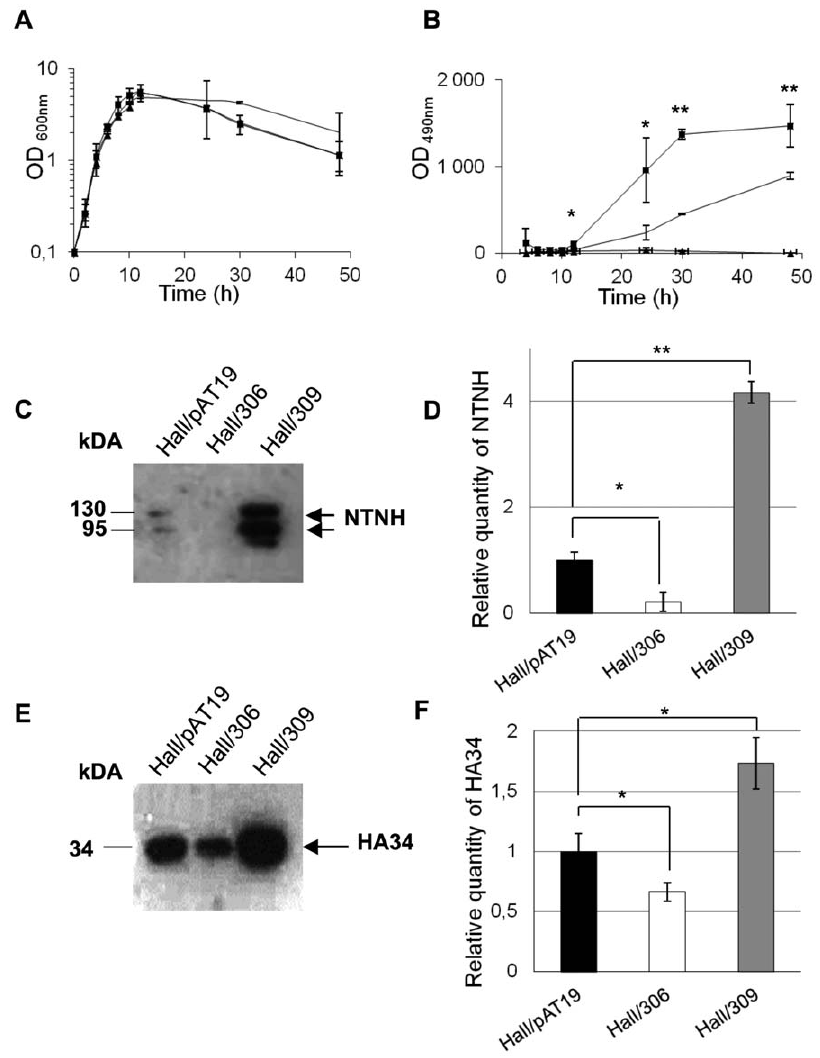
Figure 1. Growth kinetics, BoNT/A, NTNH, and HA34 production in Hall botR/A isogenic antisense strains. (A) Growth curves of Hall/ pAT19 (empty vector), Hall/306 (antisense botR/A mRNA), and Hall/309 ( botR/A overexpression) were determined by measurement of optical density at 600 nm (OD 600 ). (B) BoNT/A was assayed in the culture supernatants by ELISA and expressed as OD at 490 nm. Production of NTNH (C) and HA34 (E) were determined in the supernatant of 12 h cultures by Western blotting with specific antibodies and quantification with ImageJ (D, F) (means + / 2 SD; n=3), *P , 0.05 and **P , 0.005. Note that western blotting with anti-NTNH antibodies show native (130 kDa) and partially processed NTNH in its 115 kDa